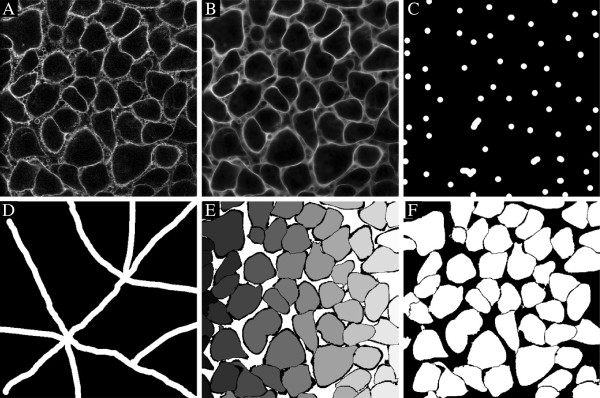
Segmentation of cells using manually drawn markers in 3D from example 9, visualized for plane five. A) Raw surface stain, B) smoothed surface stain used for segmentation, C) cell markers drawn manually, D) background markers (in an imaging plane other than the cell markers), E) watershed image, F) detected cells.